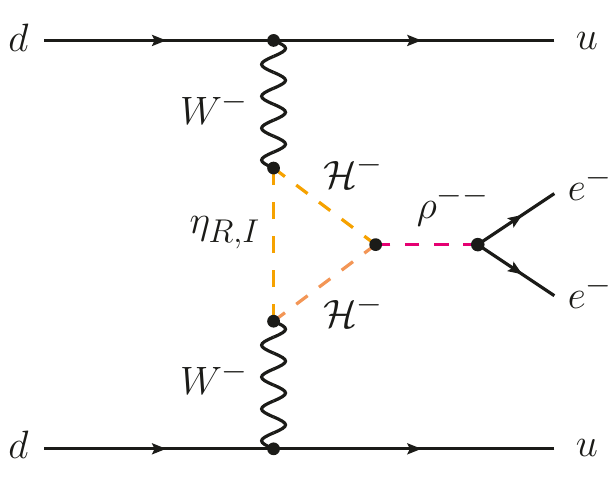
Figure 5 . 1-loop neutrinoless double beta decay diagram in the cocktail model.